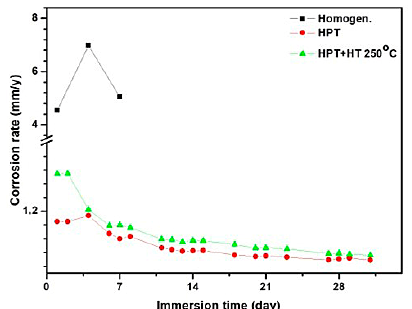
Figure 6. Corrosion rate of the Mg ‐ 1%Ca samples exposed in Ringer’s solution for a period of 1 to 32 days.